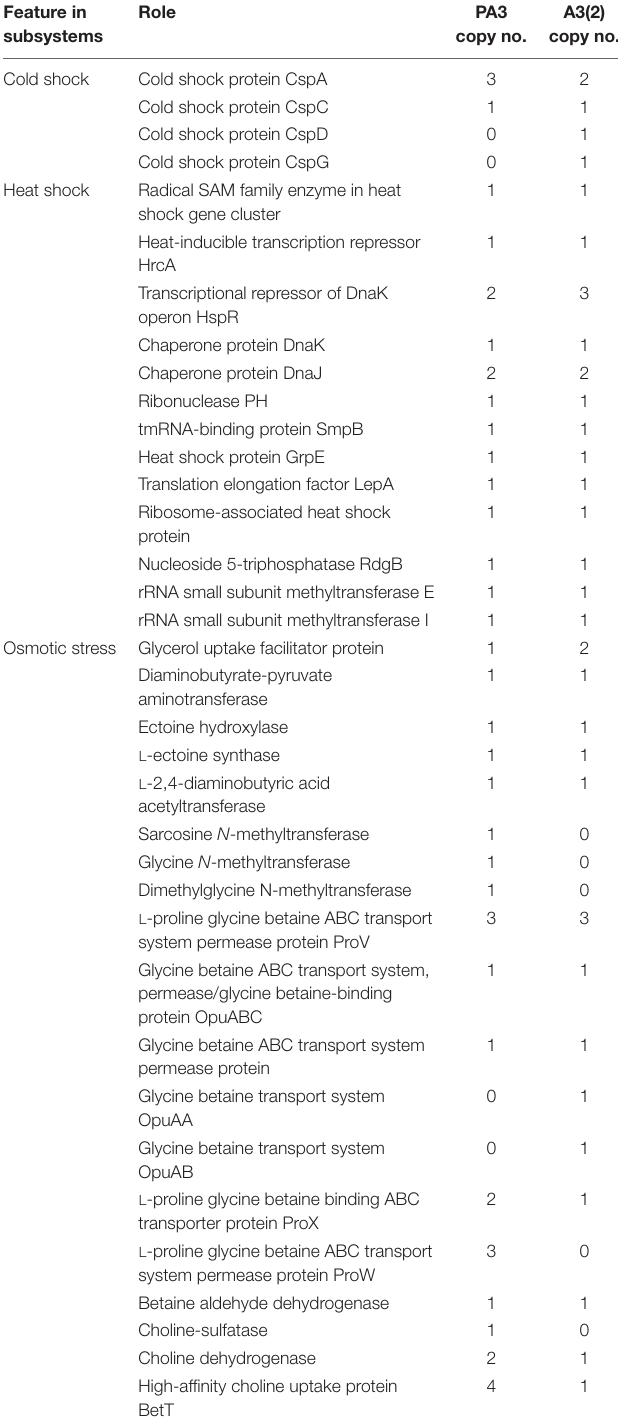
TABLE 2 | Environmental stress-related genes in Steptomonospora sp. PA3 vs S treptomyces coelicolor A3(2). Feature in Role PA3 subsystems